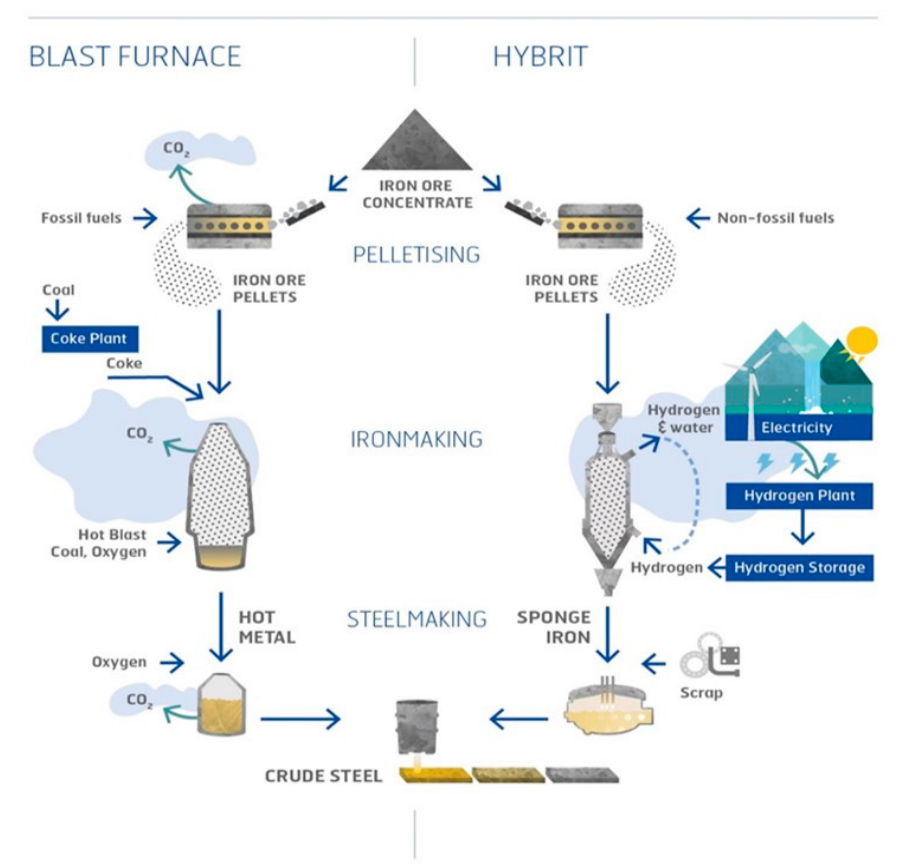
Figure 6. The blast furnace route and HYBRIT—Hydrogen Breakthrough Ironmaking Technology.